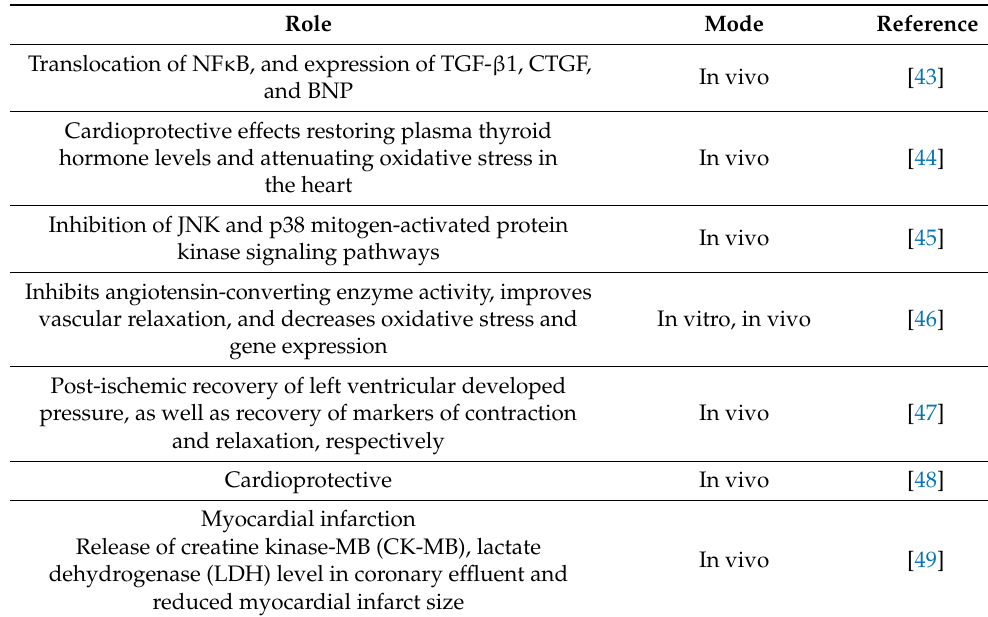
Table 1. Some recent reports on the role of quercetin as a cardioprotective